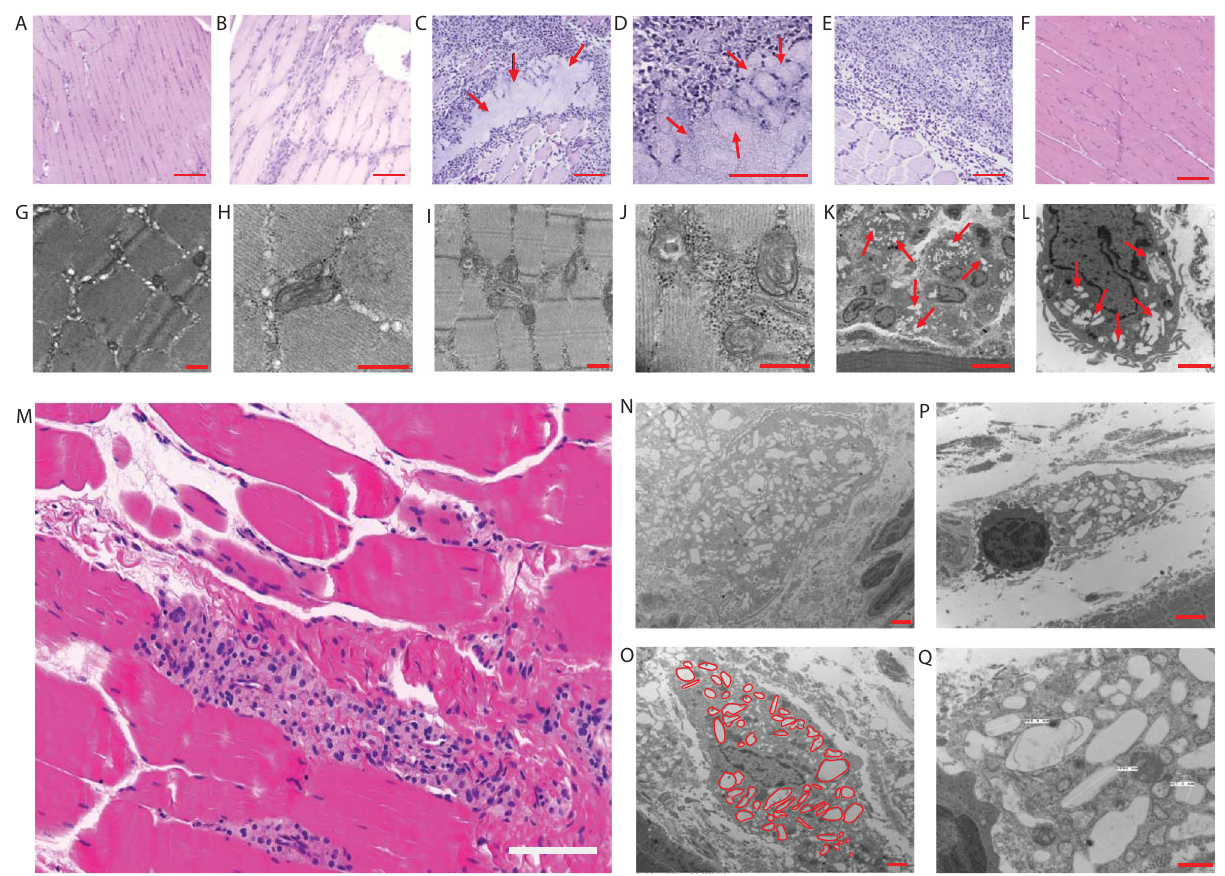
Fig. 7 Histological and electron microscopic characterization of M2DTG nanocrystals at the injection site in SD rats and rhesus macaques. A – L H&E staining of caudal thigh muscle from rats three days following IM injection. A Control (uninjected), B sham (saline-injected) control, and C – E NM2DTG (45 mg DTG-eq./kg) treated muscle sections at ×10 magni fi cation. N = 3 biologically independent animals/group with representative images shown. Representative image for C at ×10 magni fi cation has been provided at ×40 in D . F H&E staining of caudal thigh muscle from rats 57 days following IM injection of NM2DTG at 45 mg DTG-eq./kg at ×10 magni fi cation. N = 3 biologically independent animals/group with the representative image shown. Scale bars — 400 μ m ( A – C , E , F ), 200 μ m ( D ). G – L Replicate muscle samples were examined by transmission electron microscopy (TEM) from rats three days post-treatment. N = 3 biologically independent animals/group with representative images shown. G , H Uninjected and I , J sham (saline-injected) controls show normal muscle histology. K , L Rats that were injected with NM2DTG show cell in fi ltration with ingestion of the nanoformulation into endosomal vesicles (red arrows). Scale bars — 500 nm ( G – J ), 10 μ m ( K ), 2 μ m ( L ). Female rhesus macaques were given a 45 mg DTG-eq./kg IM dose of NM2DTG in the quadriceps muscles, followed by an equivalent booster dose on day 217. Animals were sacri fi ced on day 428. M H&E staining of